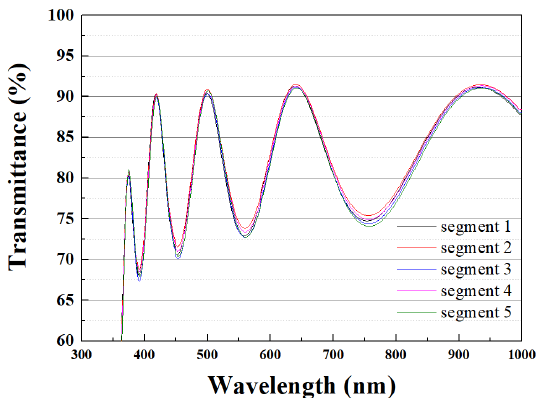
Figure 10. Transmission spectra of Nb 2 O 5 thin film deposited on different segments.